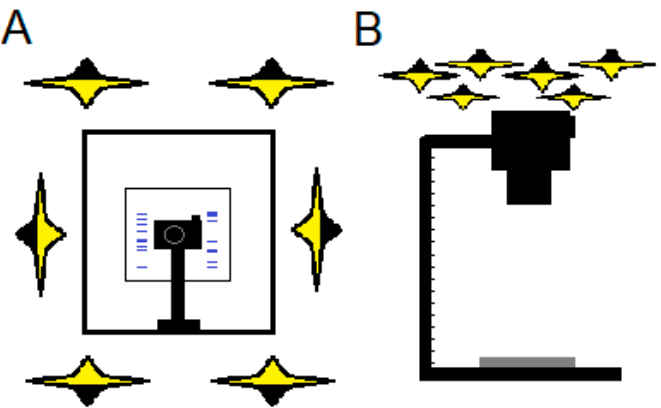
Figure 1. A schematic diagram of the photographic test bench: ( A ) top view; ( B ) side